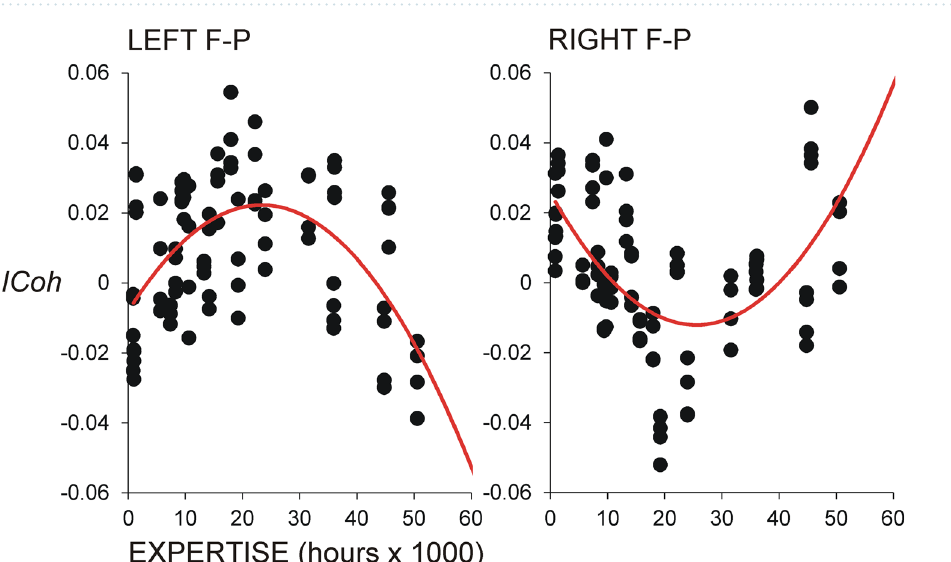
Figure 7. Results from all left and right within-hemisphere fronto-parietal (F-P) pairs for LKM. Clear opposite tendencies in the two hemispheres compared to Fig. 6 are illustrated. Designations are the same as in Fig.